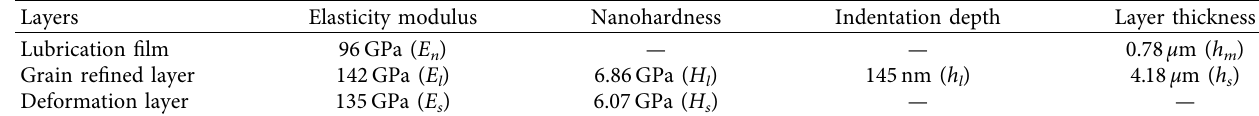
Table 1: Important parameters of the wear scar cross-section of a